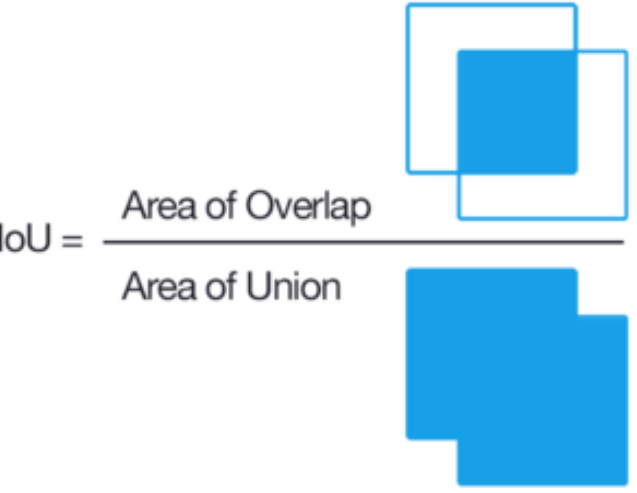
Figure 4. Representation of the Intersection over